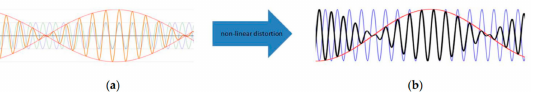
Figure 2. A non-linear distortion happening inside a non-linear medium can generate a perceivable signal of the non-linear frequencies: ( a ) out of the beating between f 1 and f 2 under the influence of a non-linear distortion in the medium ( b ) the non-linear frequencies can emerge: The sum frequency (f 1 + f 2 )/2 (dark blue) and the difference frequency (f 1 − f 2 )/2 (red) modulating its envelope. The modulated frequency (f 1 + f 2 )/2 is the carrier frequency of the modulating frequency. The Fourier frequency domain contains only the two non-linear frequencies (f 1 + f 2 )/2 and (f 1 − f 2 )/2. Pictures taken from [31,32]. Source: Mike